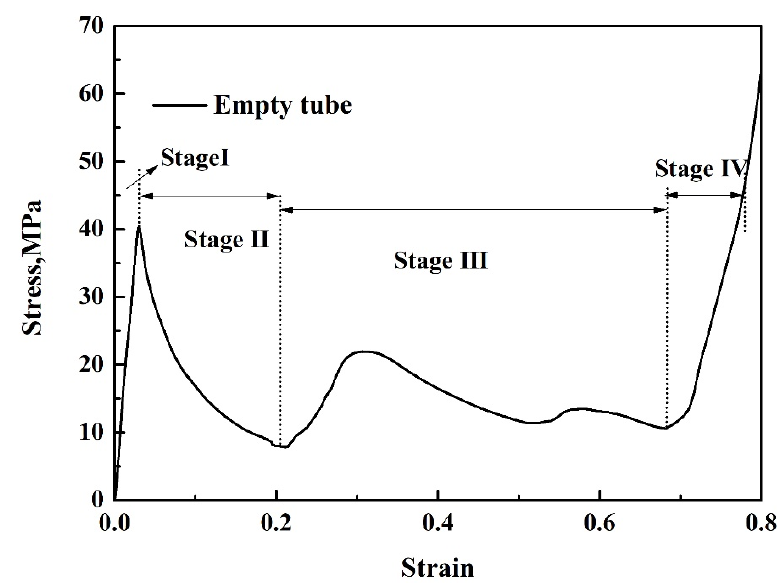
Figure 4. Stress–strain curves of the 6063 aluminium alloy empty